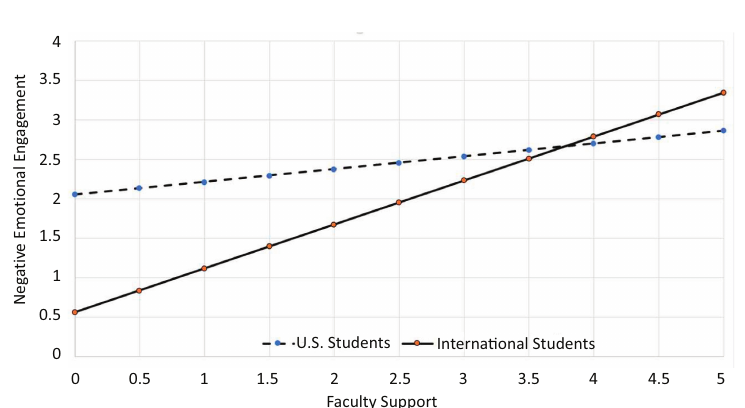
Table 9. Hierarchical regression models for negative emotional engagement